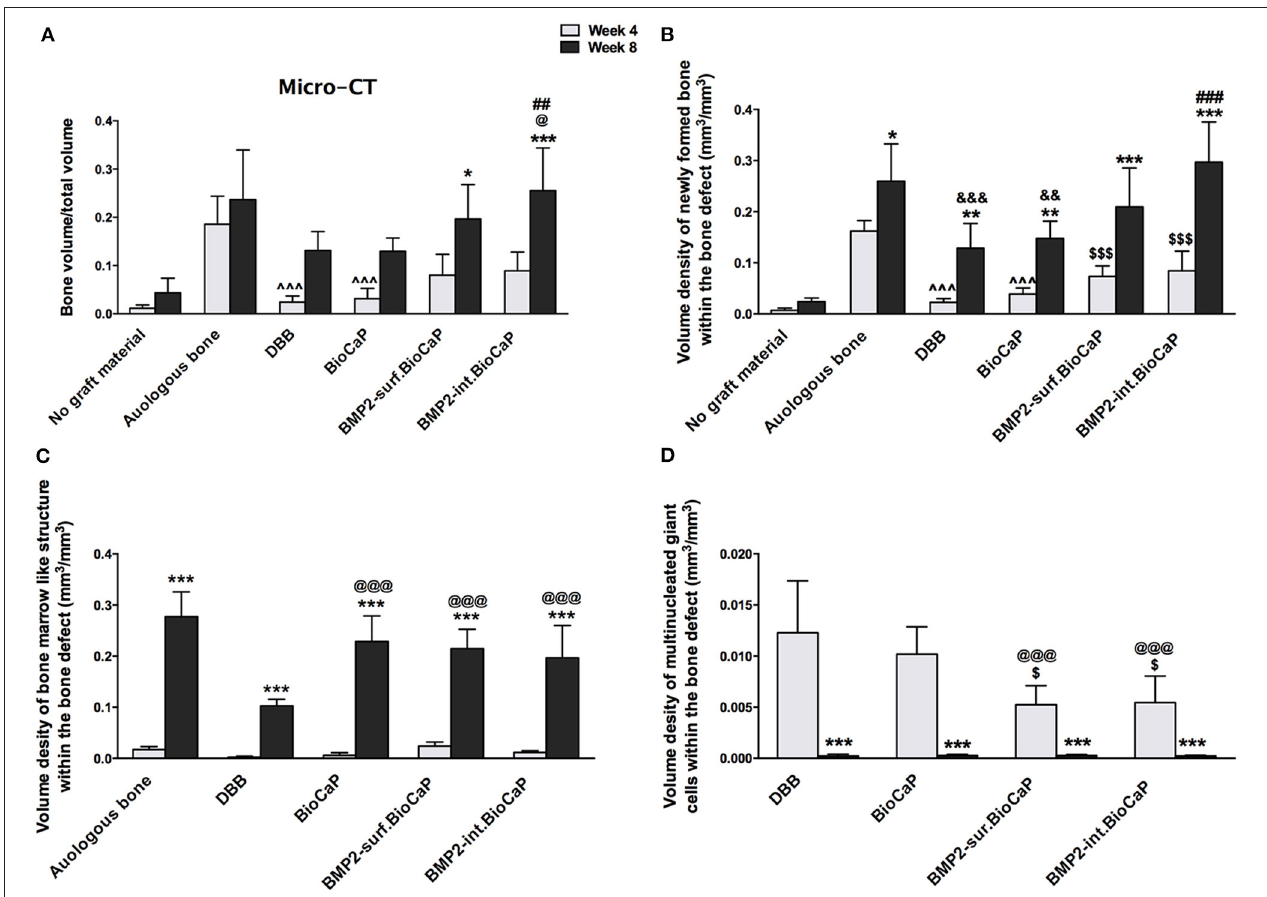
FIGURE 8 | (A) Bone volume/Total volume of newly formed bone analyzed from micro-CT data. Volume density of: (B) newly formed bone, (C) bone marrow-like structures, and (D) multinucleated giant cells analyzed form histological images. Data are presented as mean ± SD ( n = 6). Significant difference compared to respective week 4-group, * p < 0.05, ** p < 0.01, and *** p < 0.001; compared to BioCaP week 4-group, $ p < 0.05 and $$$ p < 0.001; compared to DBB week 8-group or week 4-group, @ p < 0.05, @@@ p < 0.001; compared to BioCaP week 8-group, ## p < 0.01, ### p < 0.001; compared to autologous bone week 4-group, ∧∧∧ p < 0.001; compared to autologous bone week 8-group, && p < 0.01, &&& p <